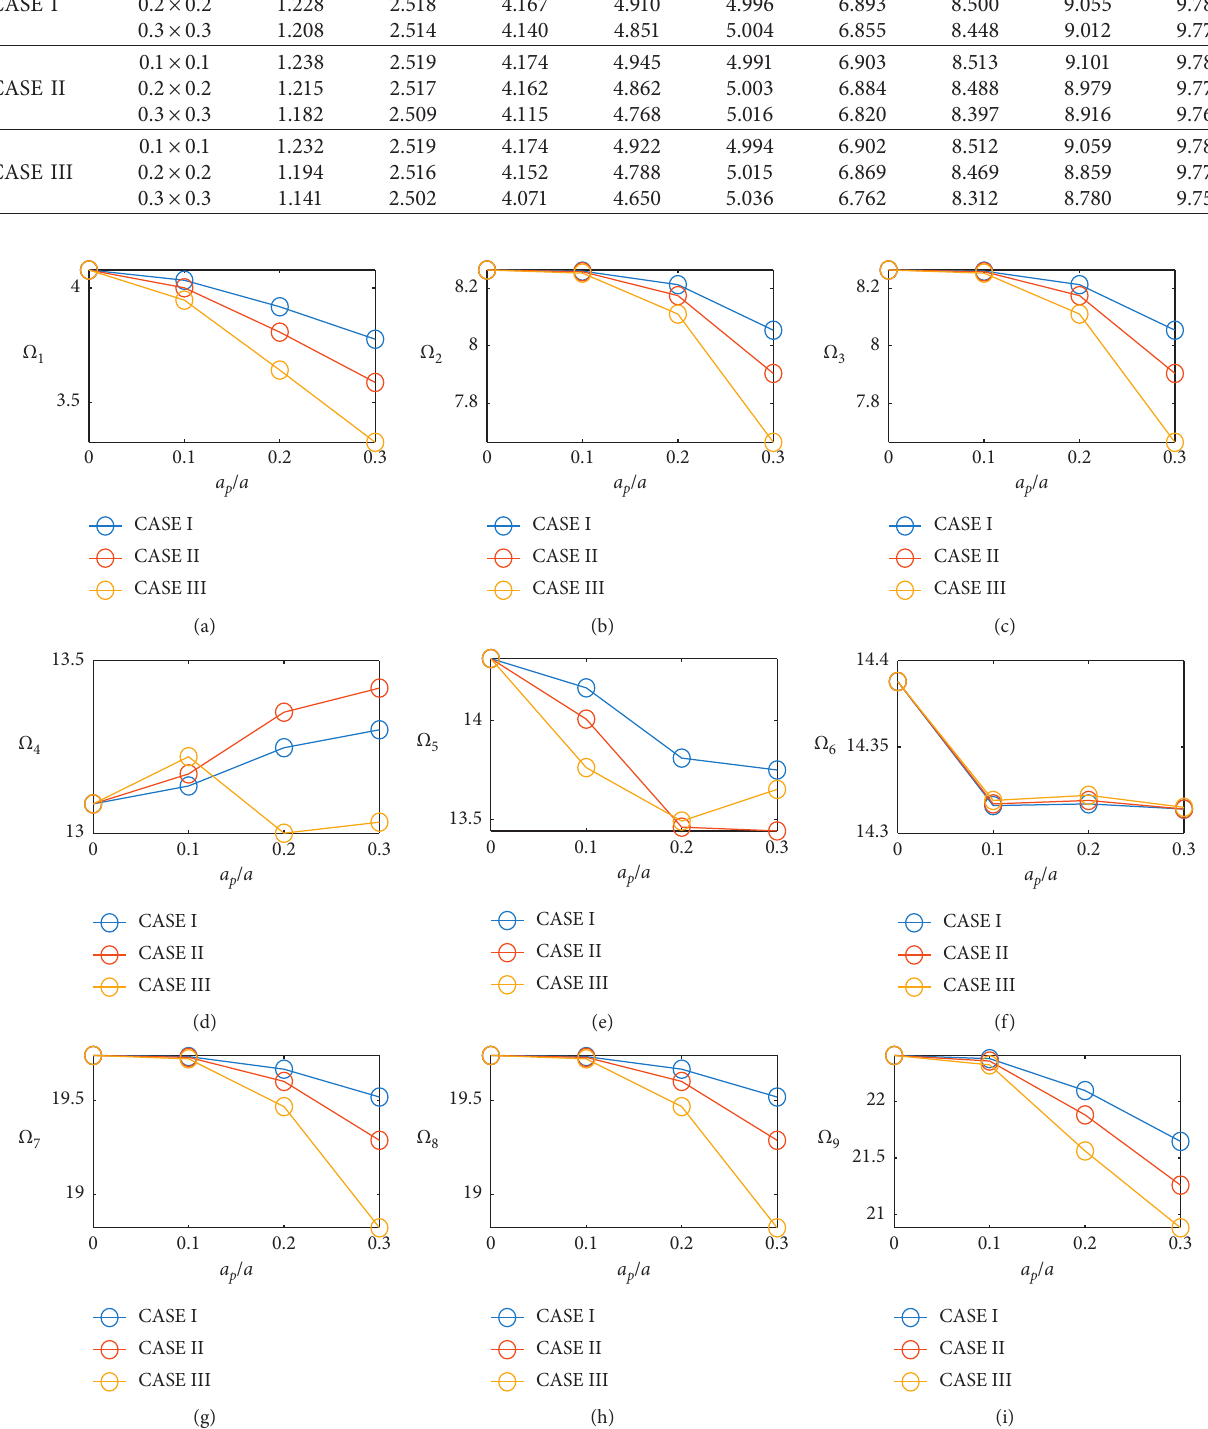
Figure 4: Nondimensional frequencies of the angle-ply laminate ([45/ − 45]s) with CCCC boundary condition, E 1/ E 2 � 10, and a � b � 10h and for different patch sizes and